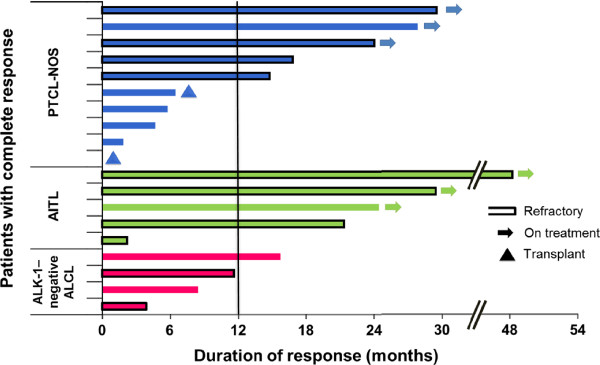
Durations of response for patients who achieved CR/CRu on romidepsin (IRC). The vertical line separates the 10 patients with long-term responses (duration ≥ 12 months). Of the 2 patients that received stem cell transplant after romidepsin, type of transplant was autologous for 1 patient, and not reported for 1 patient.